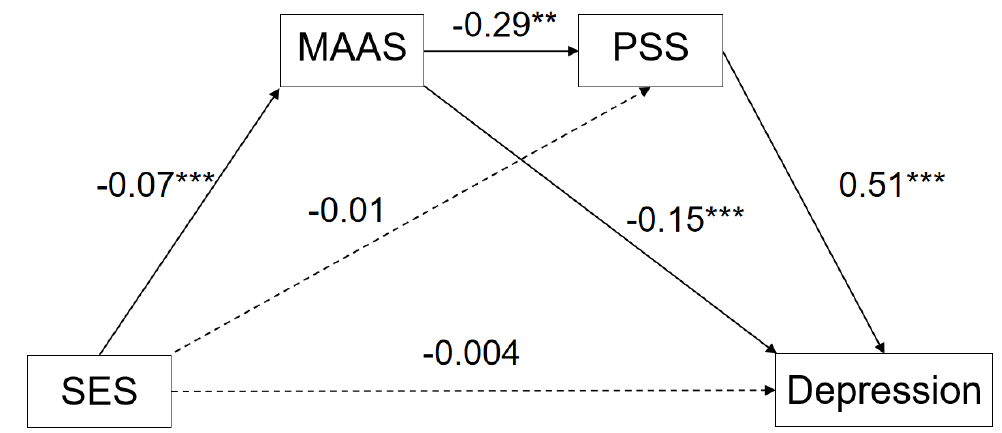
Figure 2. Serial Mediation Model of Socioeconomic to Internalizing Problems: Depression. ** p < 0.01. *** p < 0.001.